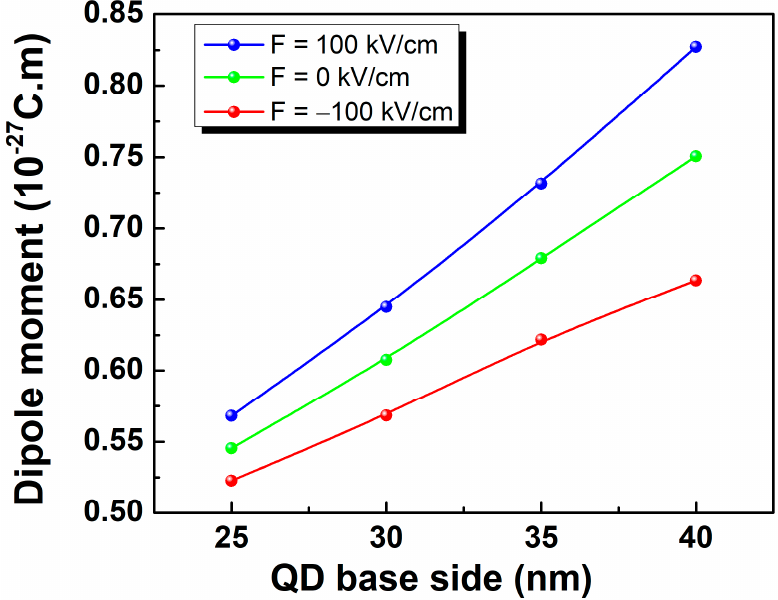
Figure 4. Intersubband dipole moment as a function of the pyramidal QD base side length for di ff erent values of the applied electric field.